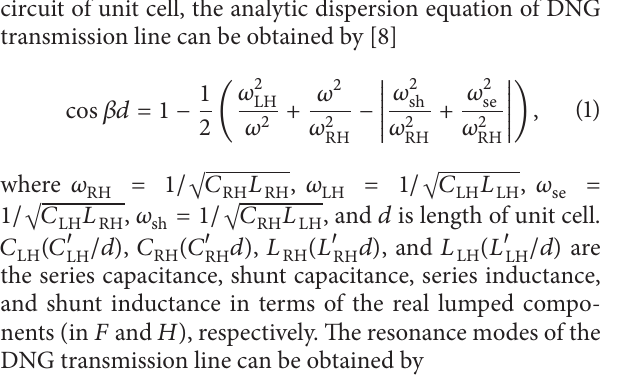
( 𝐿 󸀠 RH ), shunt capacitance ( 𝐶 󸀠 RH ) and a times-unit length series capacitance ( 𝐶 󸀠 LH ), and shunt inductance ( 𝐿 󸀠 LH ), as shown